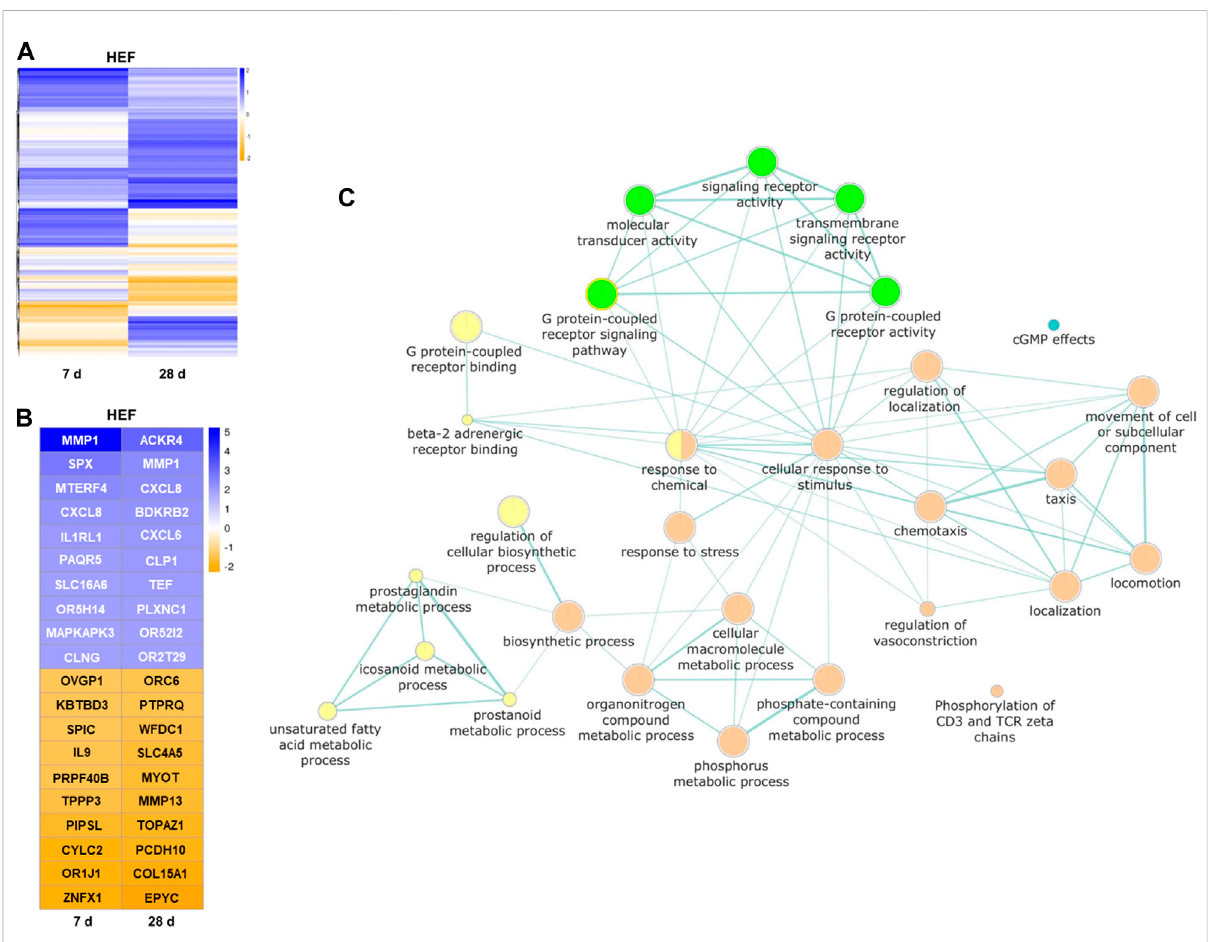
FIGURE 7 Results of the transcriptome analysis. (A) Heatmap of all genes with higher/lower fold change value than 1/-1 (log2), compared between unstimulatedcontrolcellsandHEFstimulatedcellsafter7and28 days. (B) Heatmapoftop10geneswithhighestandlowestfoldchanges(log2)each day. (C) Pathways in fl uenced by the electric stimulation. Each node (circle) represents a distinct molecular or biological function, and edges (green lines) represent the number of overlapping genes, determined using a similarity coef fi cient (Shannon et al., 2003). Yellow and orange circles representupregulatedmolecularorbiologicalfunctionsafter7(yellow)and28 days(orange)ofHEFstimulation,respectively.Greenandbluecircles represent downregulated molecular or biological functions after 7 (green) and 28 days (blue) of HEF stimulation,